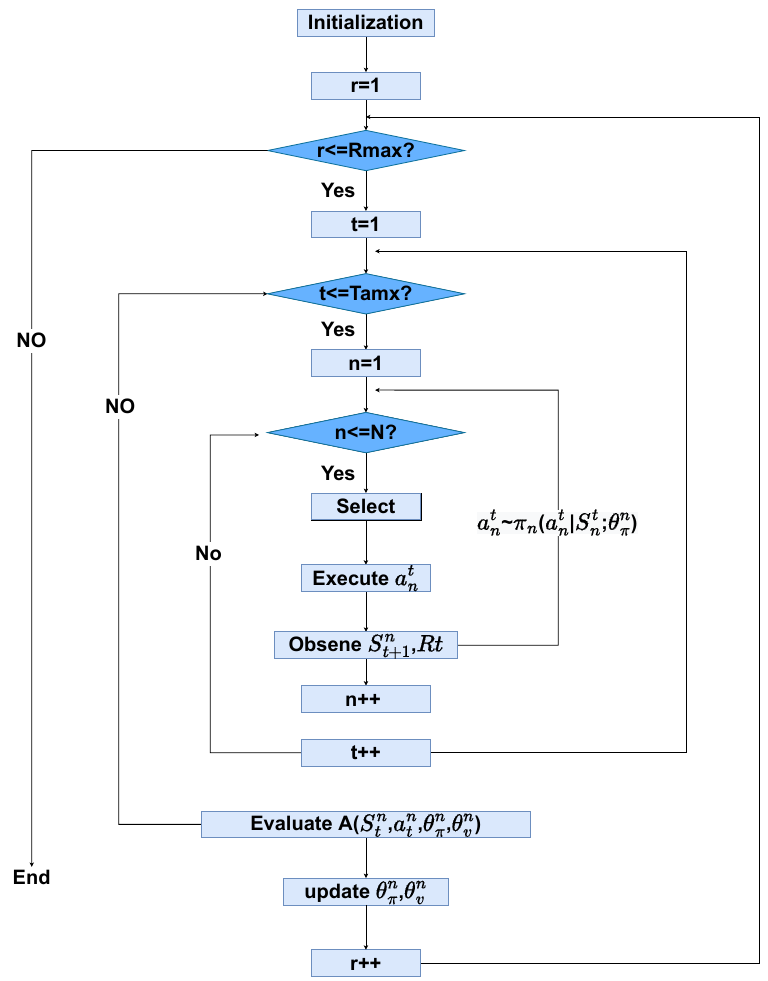
Figure A2. The detailed process of Algorithm